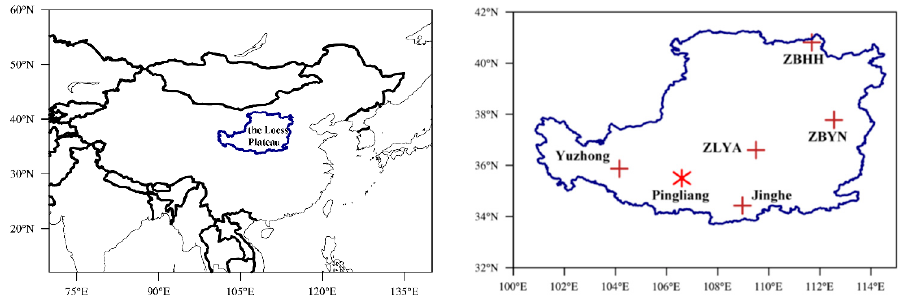
Figure 2. Locations of the six stations. Five cross markers indicate stations with only initial sounding data (at 08:00 LT). The star marker indicates Pingliang station with soil moisture, fluxes and radiosonde observations.